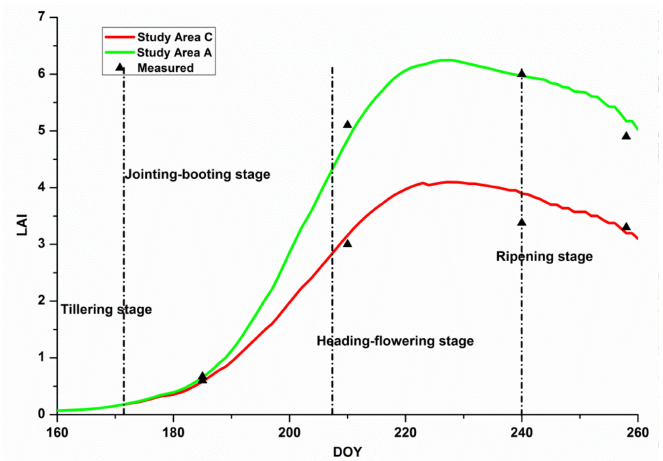
Figure 6. Dynamic simulation of the leaf area indexes (LAIs) by the optimized model for each study area.